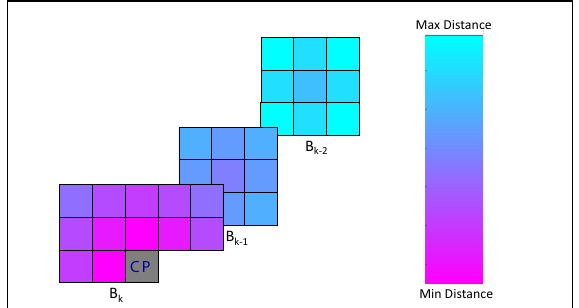
Figure 4. Spatial/spectral neighborhoods in a DPCM